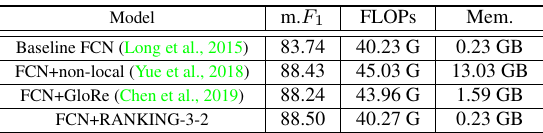
Table 3. Comparison of computational